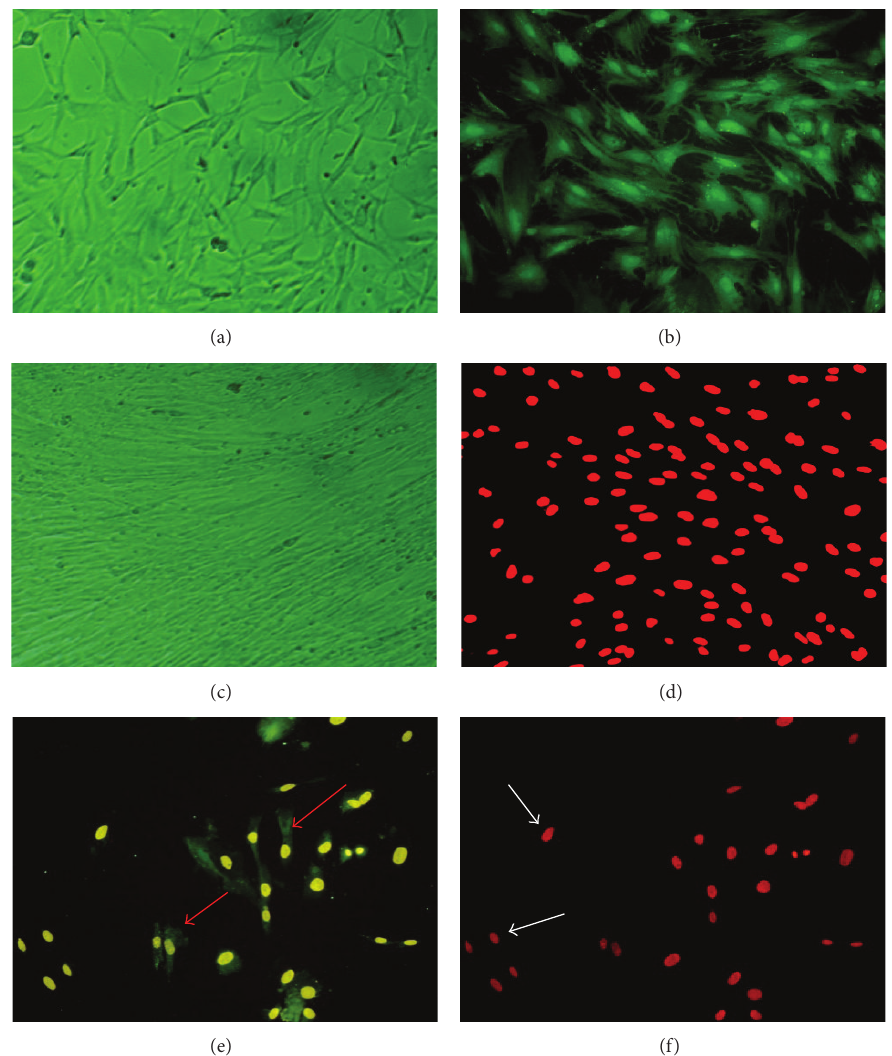
Figure 2: Morphological features of OECs, BMSCs, and coculture cells ( × 200). OECs were bipolar and multipolar, woven into a net (a). OECs were seen to express p75NTR (green, b). BMSCs were compact and the shape was like spindle (c). Brdu was found to exist in the cell core (red, d). The coculture cells, OECs were identified in the cell membrane (green, e) and cell core (yellow, e) (red arrow); BMSCs were identified in the cell core (red, f) (white arrow) and not in the cell membrane (green, f).